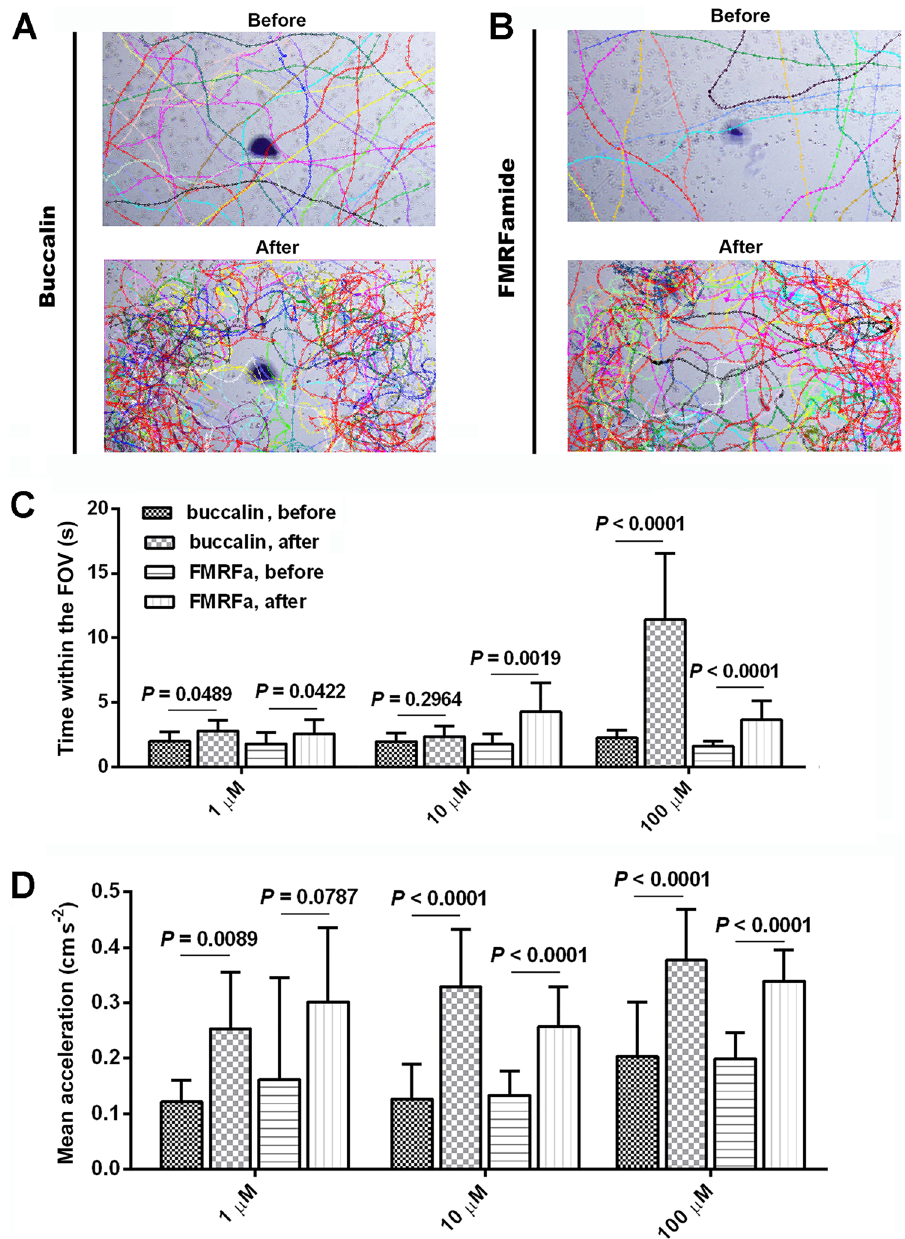
Figure 3. Miracidial behaviour assay using buccalin and FMRFa peptides. ( A ) Representative trajectories of miracidial movement before and after the addition of the buccalin solution (100 µM) to the center of the recording area. Each colour represents one indistinguishable miracidium individual. See Movie S1 for representative assay video. ( B ) Representative trajectories of miracidia movement before and after the addition of the FMRFa solution (100 µM) to the center of the area. Each colour represents one indistinguishable miracidium individual. See Movie S2 for representative assay video. ( C ) Graph of time duration of miracidia remaining in the videoing zone, and ( D ) mean acceleration values, before and after the addition of buccalin and